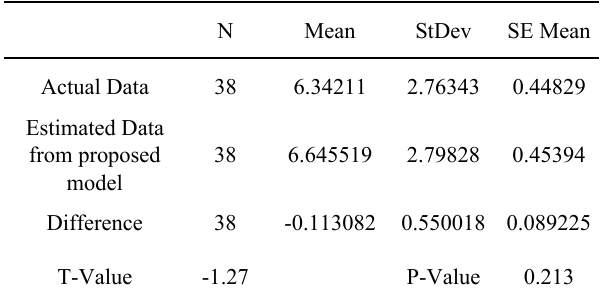
Table 5. Actual Collected Data and the Proposed Model